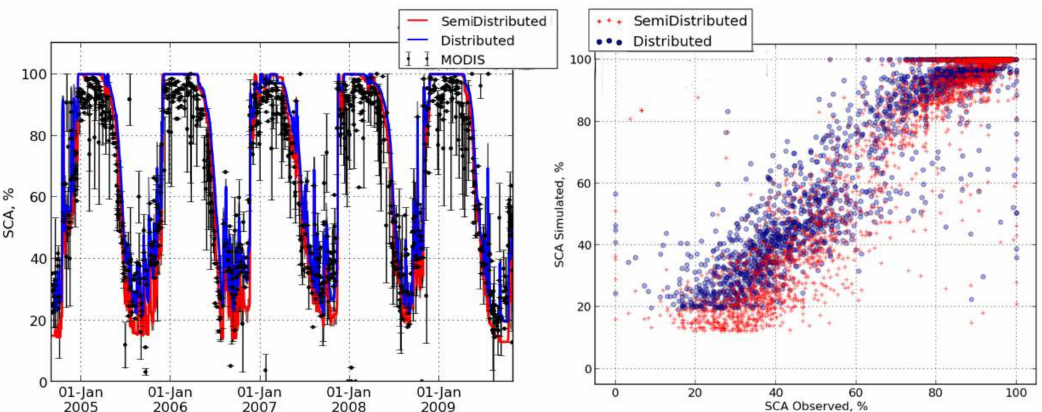
Figure 6. ( Left ) Temporal evolution of the SCA (2005–2010) based on semi-distributed and distributed simulations and MODIS sensor observations. The vertical bars associated with the MODIS observations show the uncertainty associated with cloud presence for days having ≤ 20% snow cover. ( Right ) Scatter plot between observed ( X axis) and simulated ( Y axis) SCA obtained with semi-distributed and distributed approaches for the whole time period with